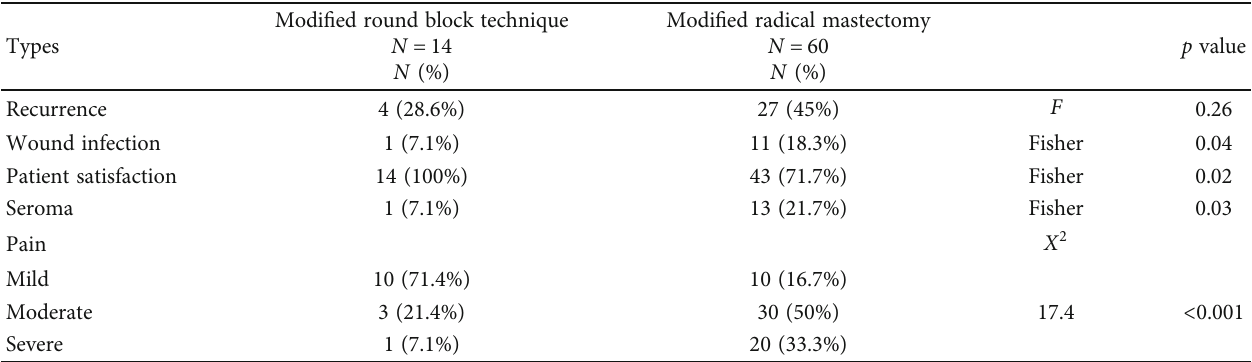
Table 11: Operative outcomes among both studied groups.